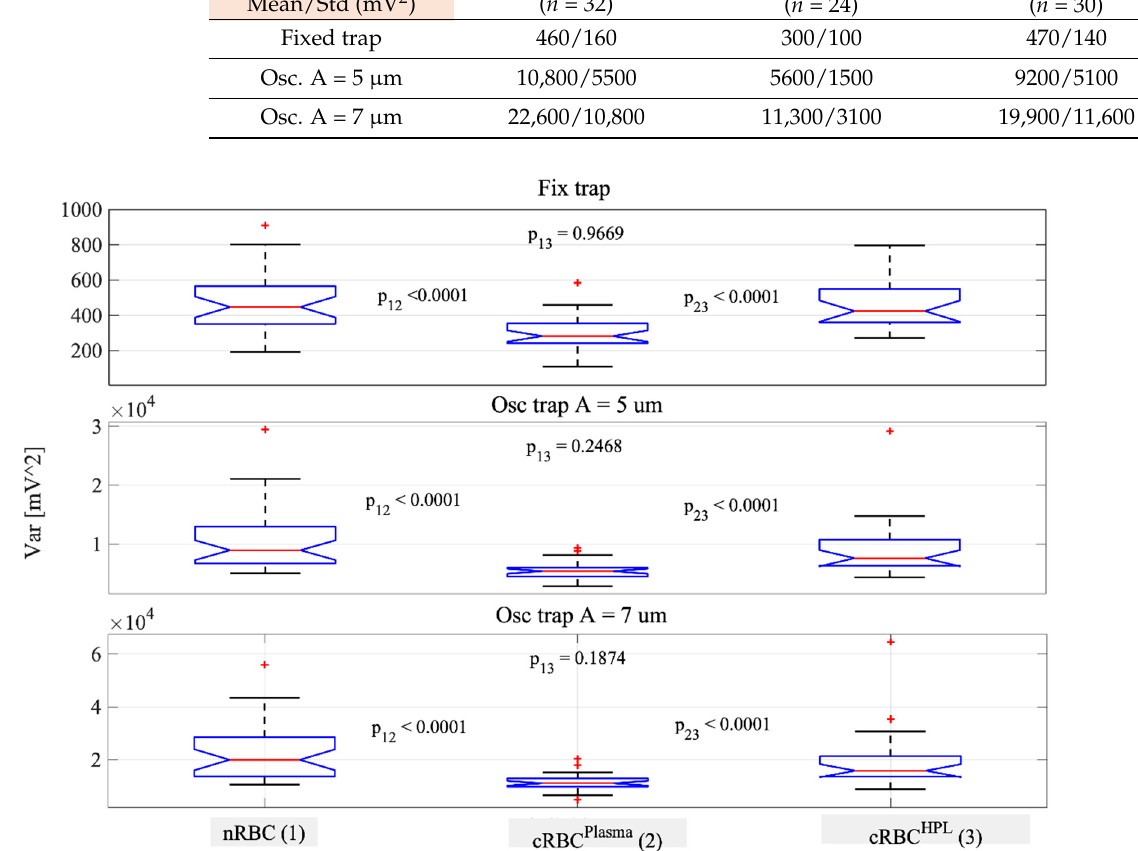
Figure 4. Variance results for nRBCs, cRBC Plasma and cRBC HPL for fixed and oscillating traps: A = 5 µm and A = 7 µm, respectively. The distributions of the variance values for each cell type are represented graphically using the boxplot method. The p values are calculated with a Mann–Whitney U test.